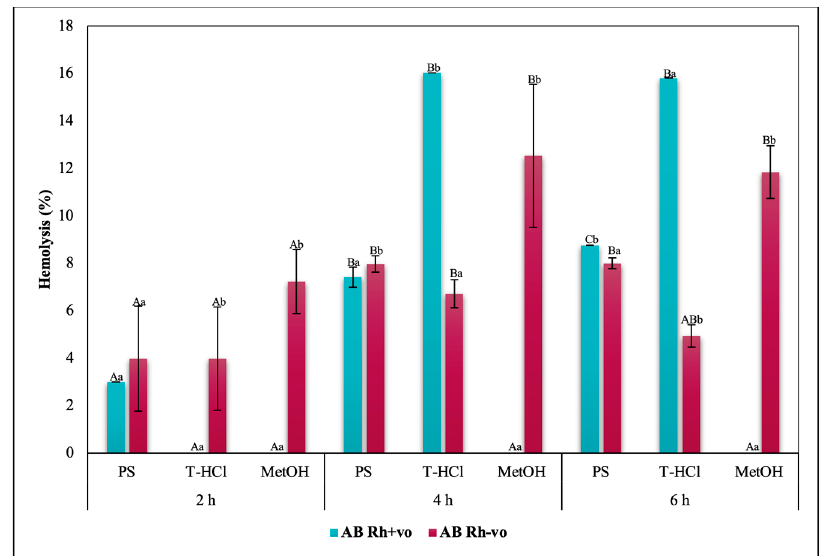
Figure 8. Blood biocompatibility assay of P. cruentum extracts on human erythrocytes with different RhD (positive and negative) of AB blood group. Different letters represent significant differences in the means between treatments and groups ( p ≤ 0.001). Capital letters represent a two-way ANOVA. Lowercase letters represent a univariate ANOVA between extracts for each exposure period. PS, extract of physiological solution; T-HCl, 0.5 M Tris-HCl extract; MetOH, 99% methanol extract; AA, ascorbic acid; BCT, beta-carotene; FXA, fucoxanthin.